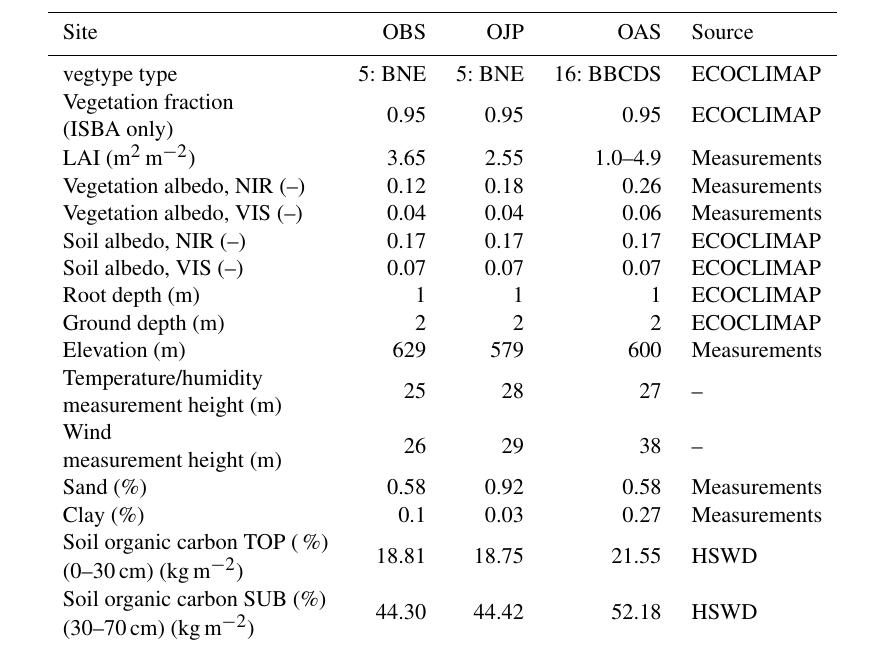
Table 2. Model characteristics prescribed for the three different